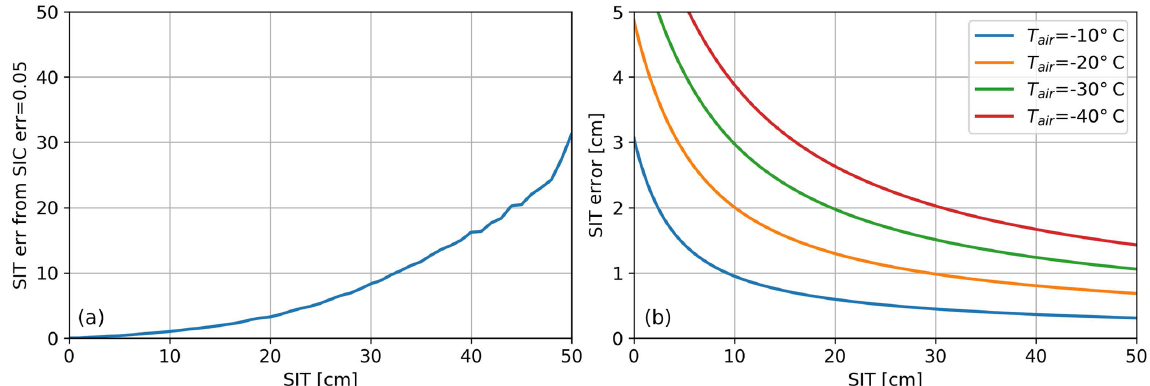
Figure 9. (a) SIT error with change of SIT for a SIC uncertainty of 5%. (b) SIT error as a function of SIT due to CFDD daily variability calculated for various fixed 2m air temperatures.